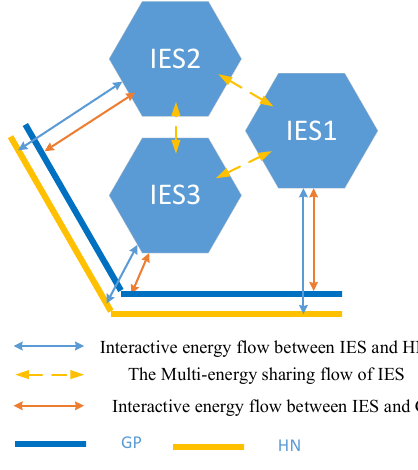
Figure 2. Multi-energy sharing architecture.